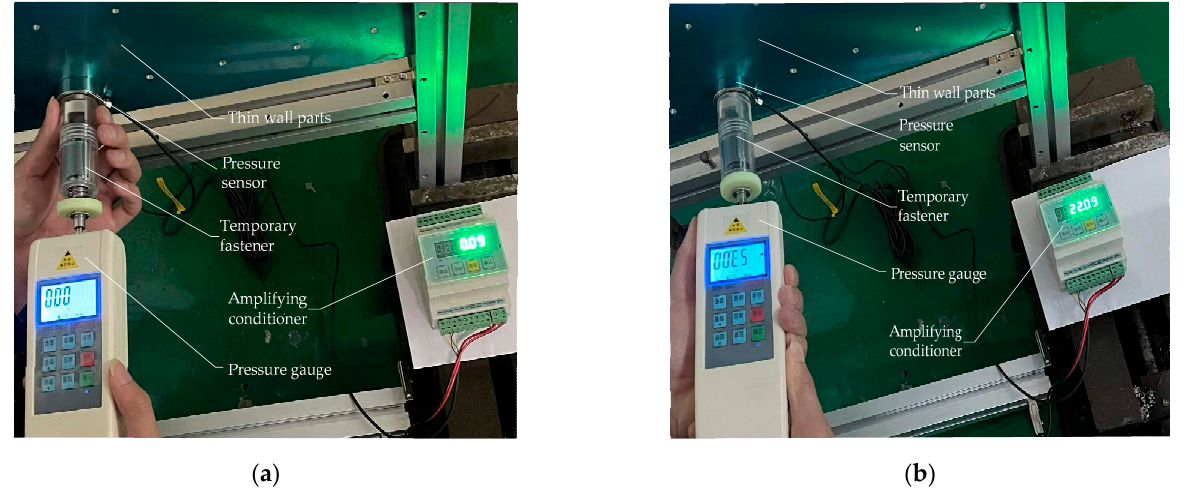
Figure 18. ( a ) The physical diagram of the experiment device; ( b ) Experimental measured results.